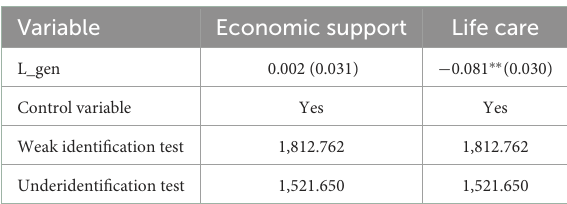
TABLE 10 Test results of instrumental variables of children’s parental support